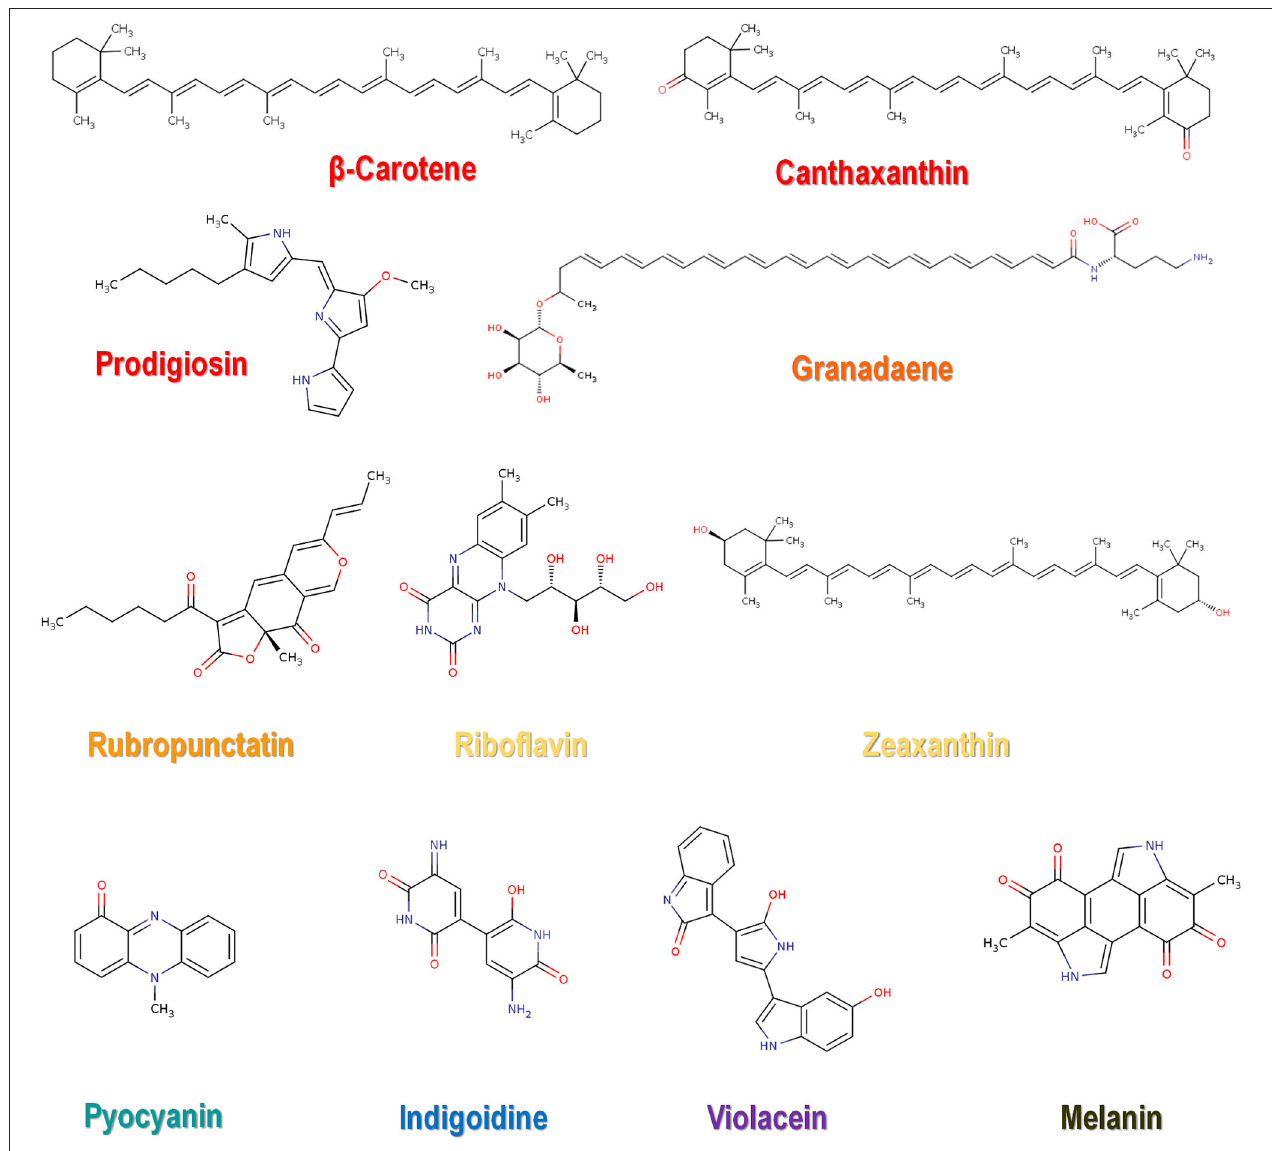
FIGURE 1 | Chemical structure of some representative microbial